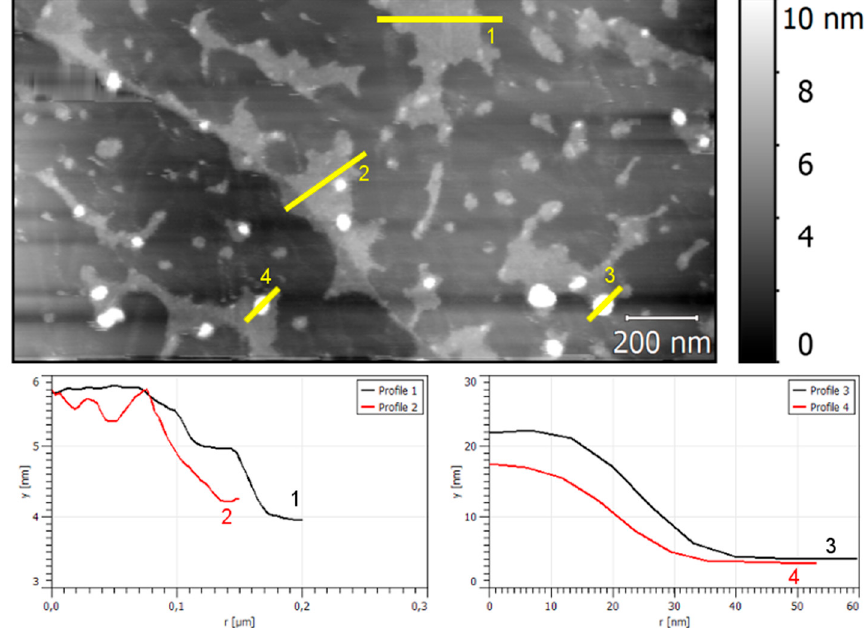
Figure 10. AFM image of a sample electrodeposited at − 2 V vs. Ag/AgCl showing the radial profiles measurements of the two populations of deposited structures.